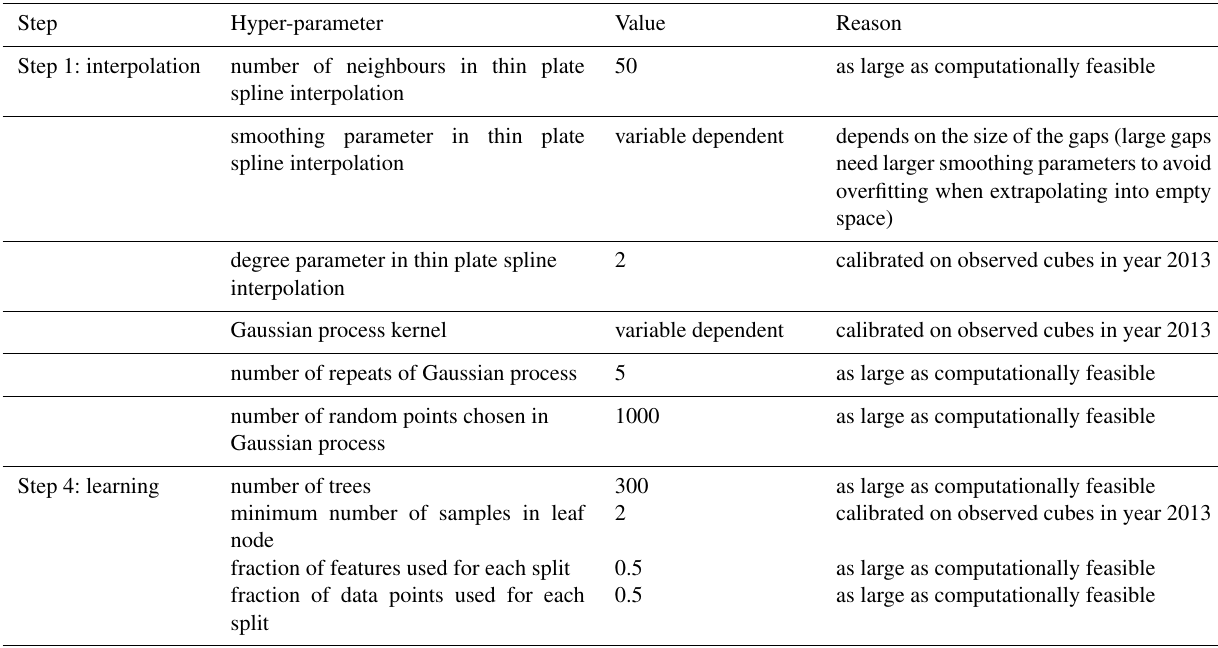
Table A2. Hyper-parameters of each step, their respective values, and how they were